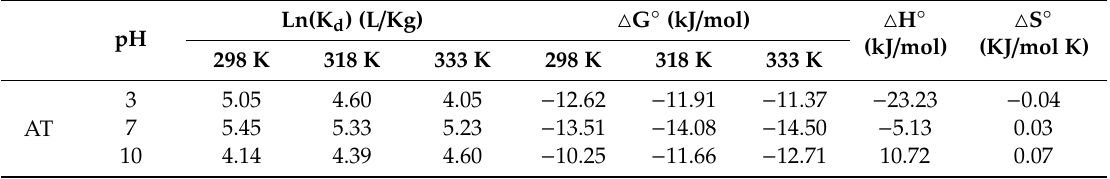
Figure 6. AT adsorption on SAz-2 as affected by equilibrium temperature at pH 3, 7 and 10 under initial AT concentration of 3 mmol/L. Table 1. Thermodynamic values of AT adsorption on SAz-2 under different temperatures.